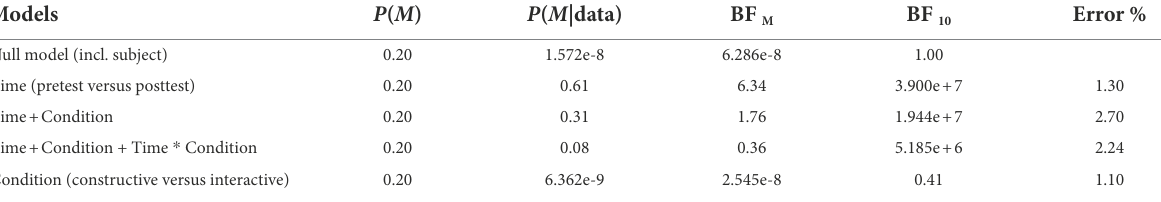
TABLE 4 Model comparison for the Bayesian repeated measures ANOVA on skill.